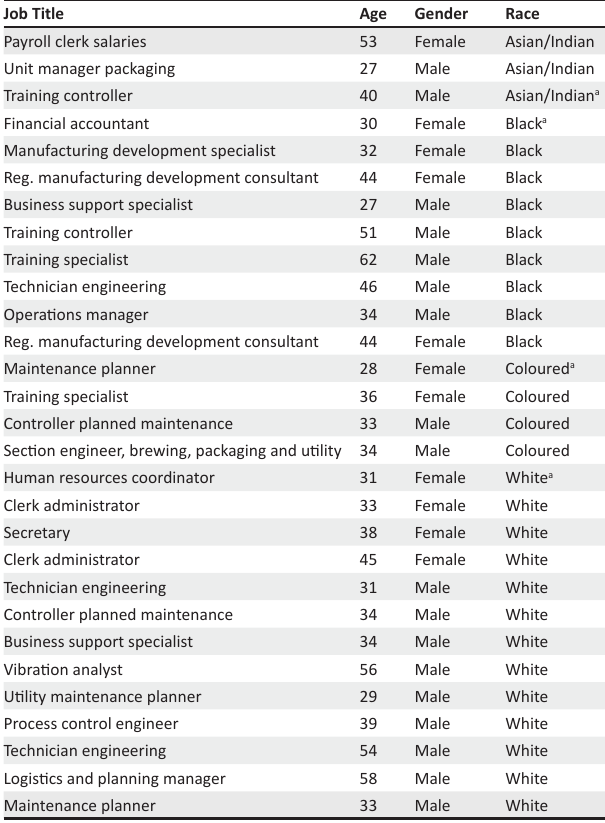
TABLE 1: Socio-demographic profile of